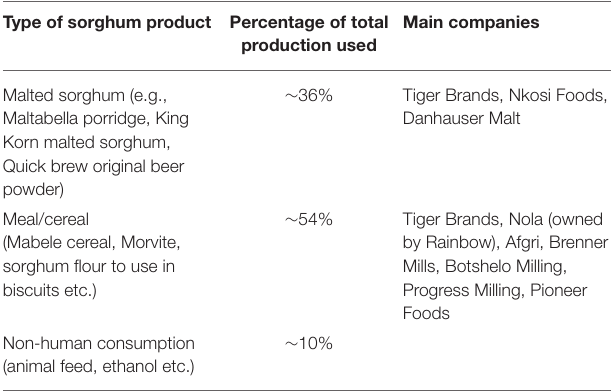
TABLE 2 | Table of commercial sorghum products for human consumption in the mainstream market (based on data from SAGIS and Grain SA). Type of sorghum product Percentage of total Main production used